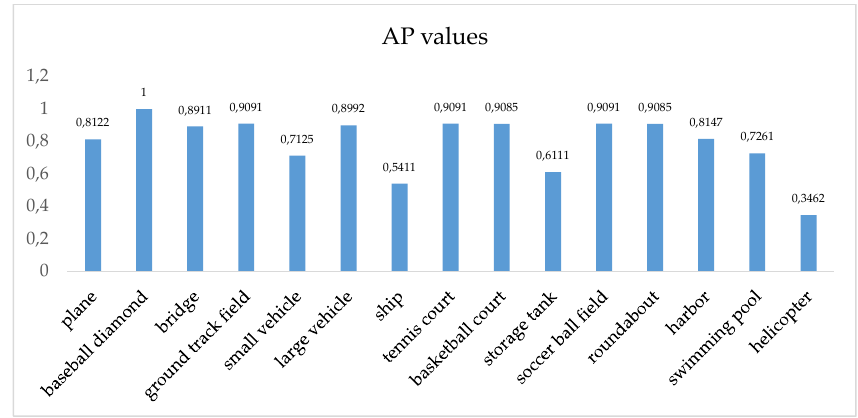
Figure 8. The average precision (AP) values of the different classes in the proposed method.